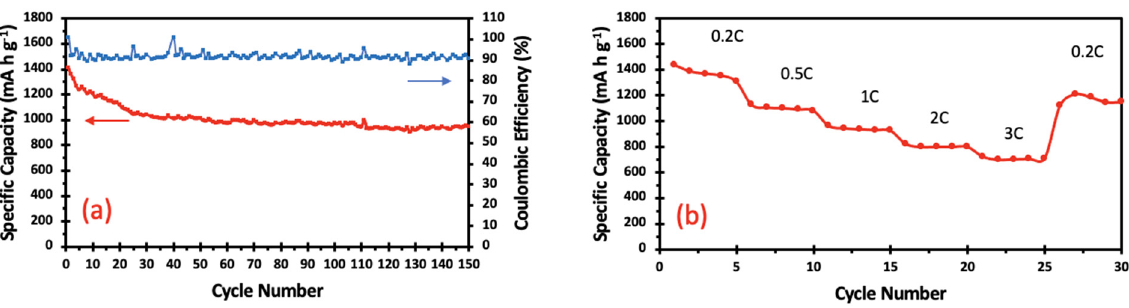
Figure 5. ( a ) Long-term capacity retention of the cathode at 0.2 C, ( b ) variable rate performance of S@RGO/GN cathode.